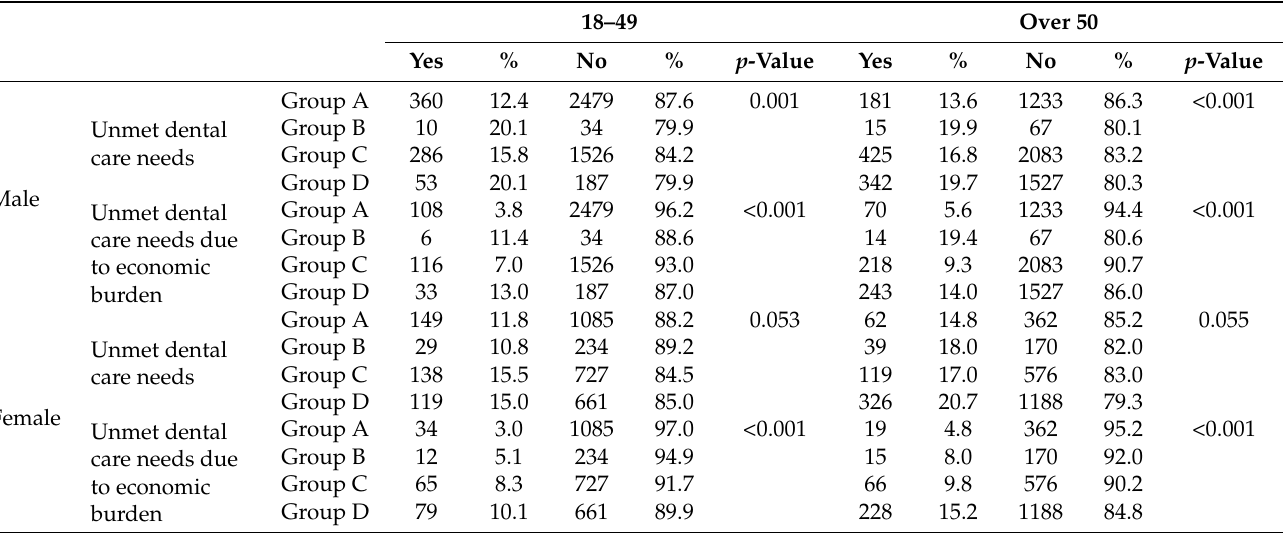
Table 3. Rates of unmet dental care needs according to the characteristics of Korean workers from the Korea Health Panel Survey (2011 – 2017) † .